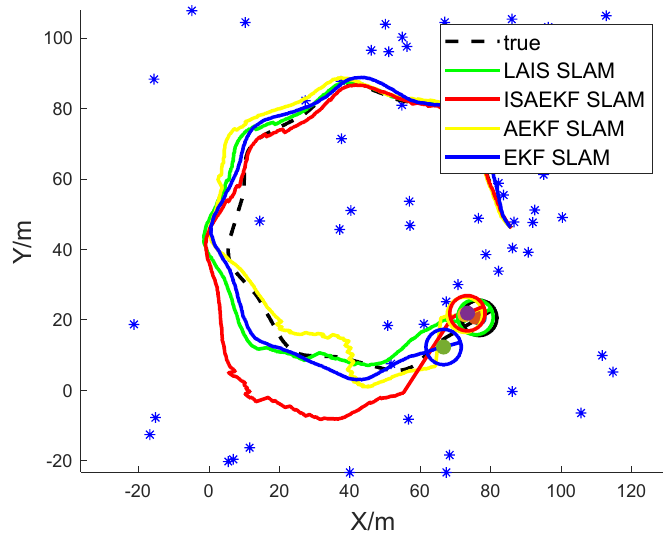
Figure 3. Trajectory diagram of each algorithm.